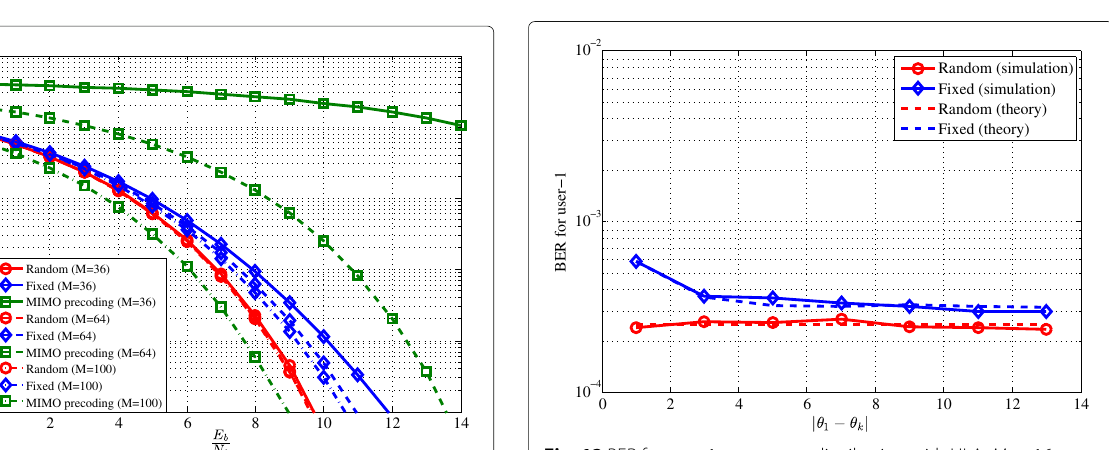
Fig. 12 BER for user-1 versus user distribution with ULA : M = 16, K = 14, E b / N 0 = 8